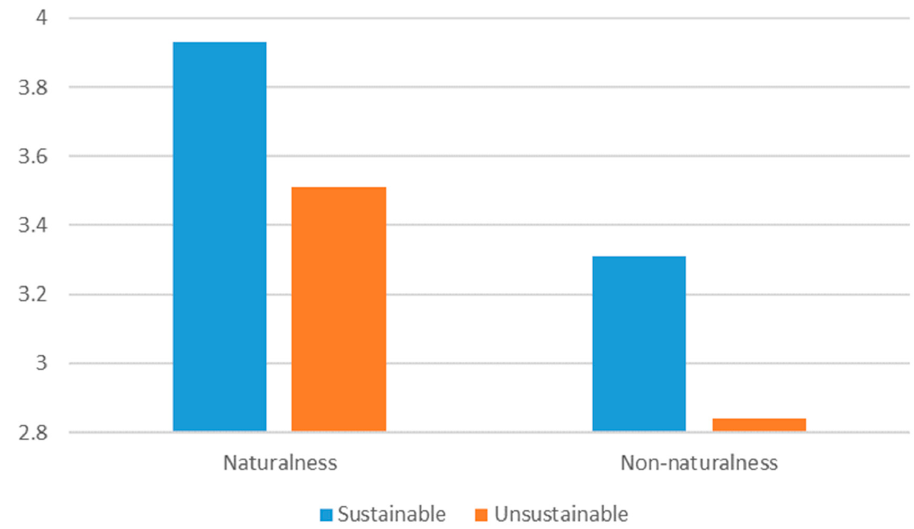
Figure 4. The effect of naturalness and sustainability on eco-friendliness. Table 4. Summary of the main effects and interactions of eco-friendliness.